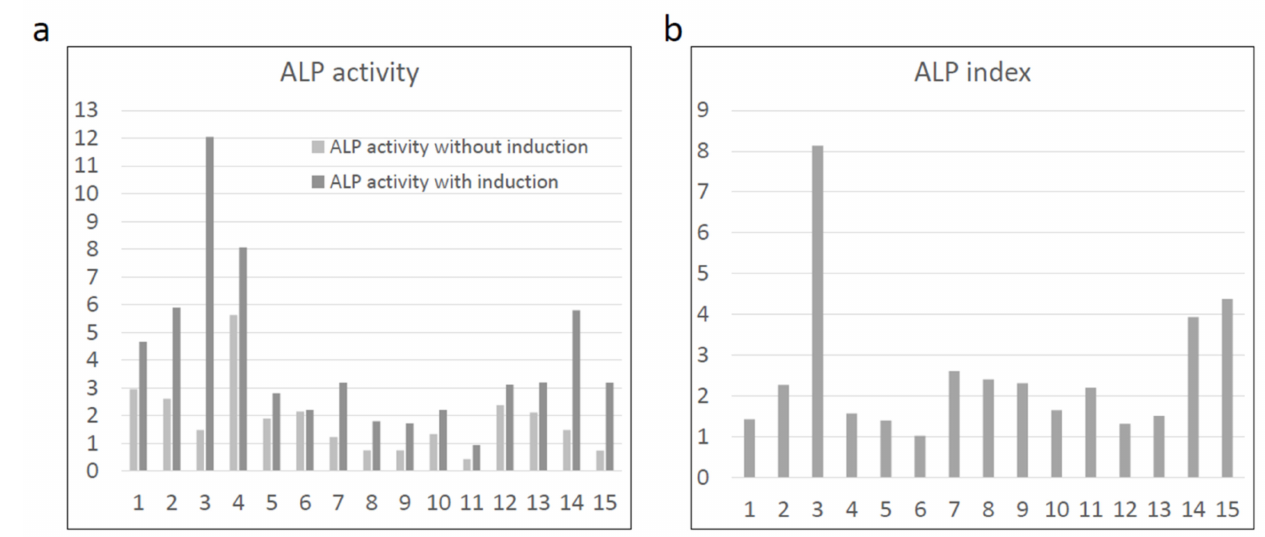
Figure 2. Osteogenic differentiation capability of BMSCs. ( a ) Alkaline phosphatase (ALP) activity were increased in all samples after osteogenic induction. ( b ) All samples showed ALP index higher than 1, fulfilling the requirement of quality assurance in this